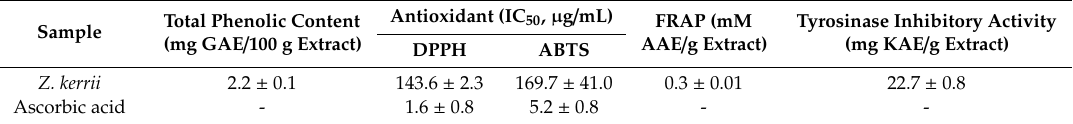
Table 2. Total phenolic content, antioxidant activity, and tyrosinase inhibitory activity of Z. kerrii rhizome extract.